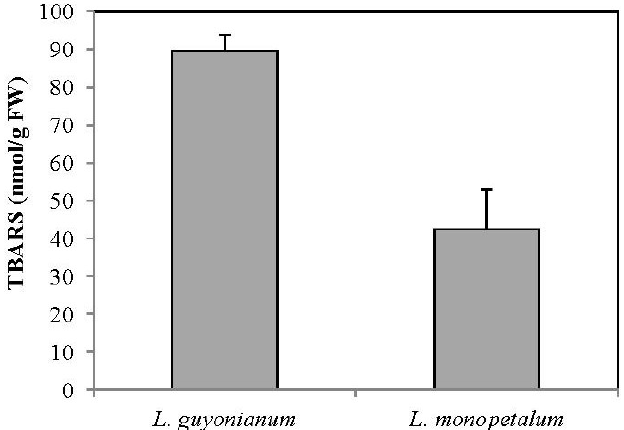
Figure 1. Thiobarbituric acid-reactive substances (TBARS) in leaves of Limoniastrum guyonianum and Limoniastrum monopetalum . Data are means of at least three replicates ± SD at p ≤